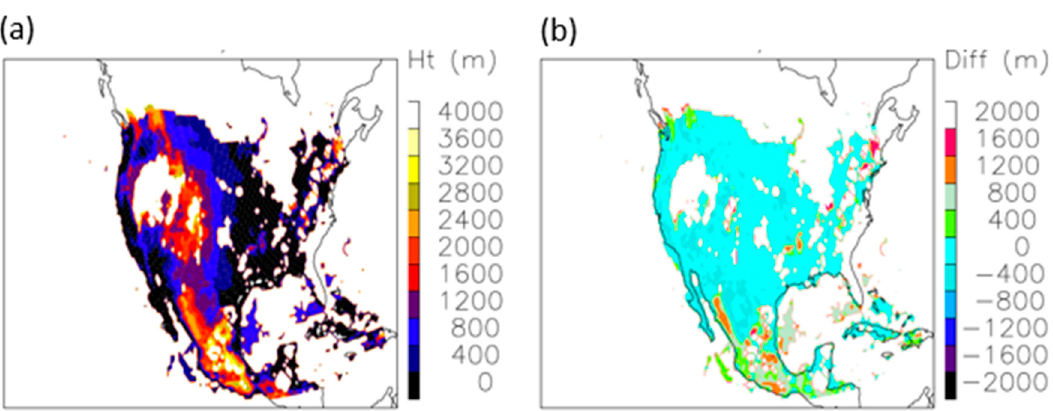
Figure 32. ( a ) Terrain height with stereo retrievals from the B02 CONUS-FD stereo; and ( b ) stereo height above terrain for wind speed < 1 m/s, which indicate the retrieval bias from the true terrain height. The stereo heights with wind speed < 1 m/s are averaged to a 0.5° × 0.5° longitude–latitude grid from all daytime hours on 26 July 2019.